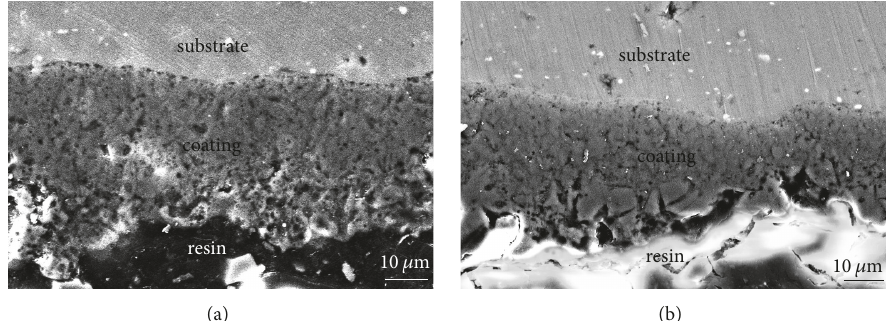
Figure 13: SEM micrographs showing cross sections of (a) MAO and (b) SMAO oxide deposits.